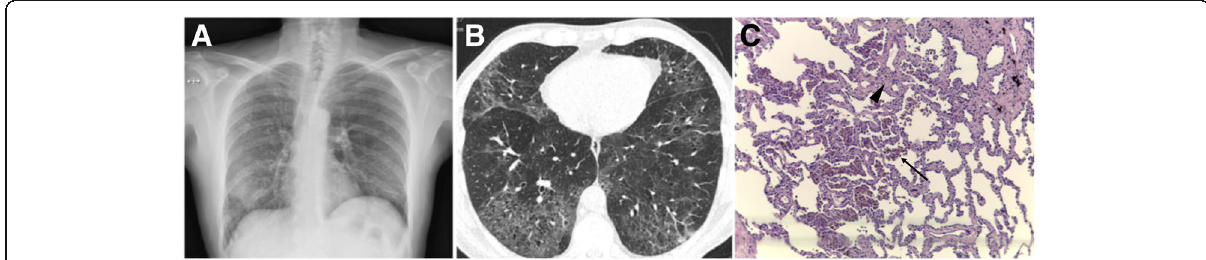
Fig. 16 DIP in a 58-year-old heavy-smoker man. a Posteroanterior (PA) radiograph shows reticular opacities and ground-glass attenuation in both lungs, predominantly in the lower lung zones. b Axial CT image shows ground-glass opacities with cystic changes in the lower and mid lobes and lingula. Images show well-defined areas of sparing, creating a mosaic attenuation. Mild areas of reticulation and bronchiectasis are also present, signifying fibrosis. c Large numbers of alveolar macrophages with light brown granules filling the cytoplasm (arrow); mild interstitial lymphocytic infiltrate and mild fibrosis (arrowhead) (H&E, ×